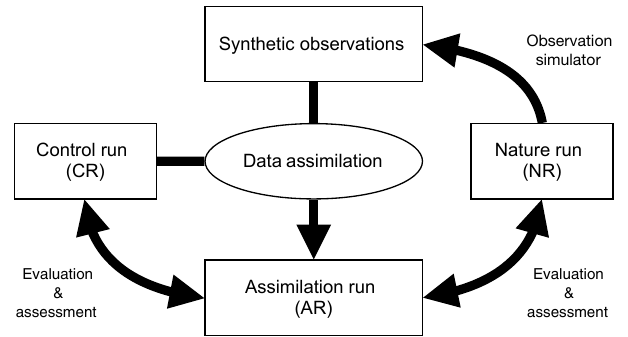
Figure 1. General flowchart of the BEATBOX system.